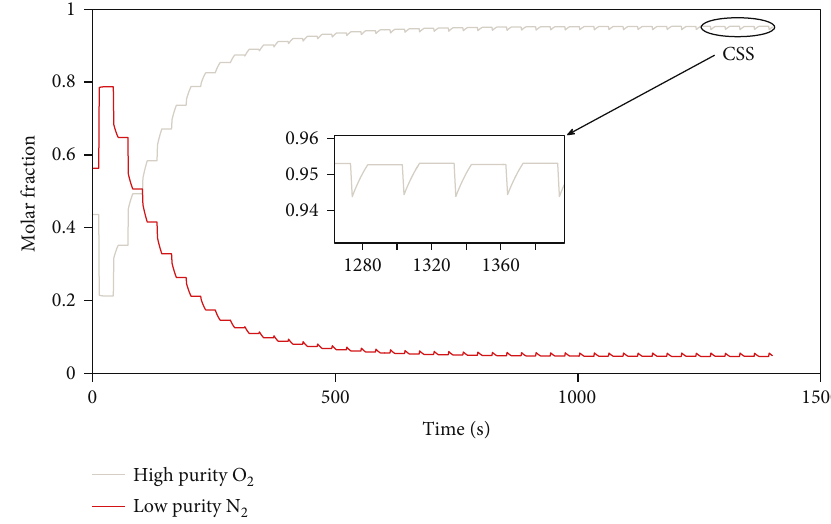
Figure 10: Puri fi cation and production of medical oxygen from the